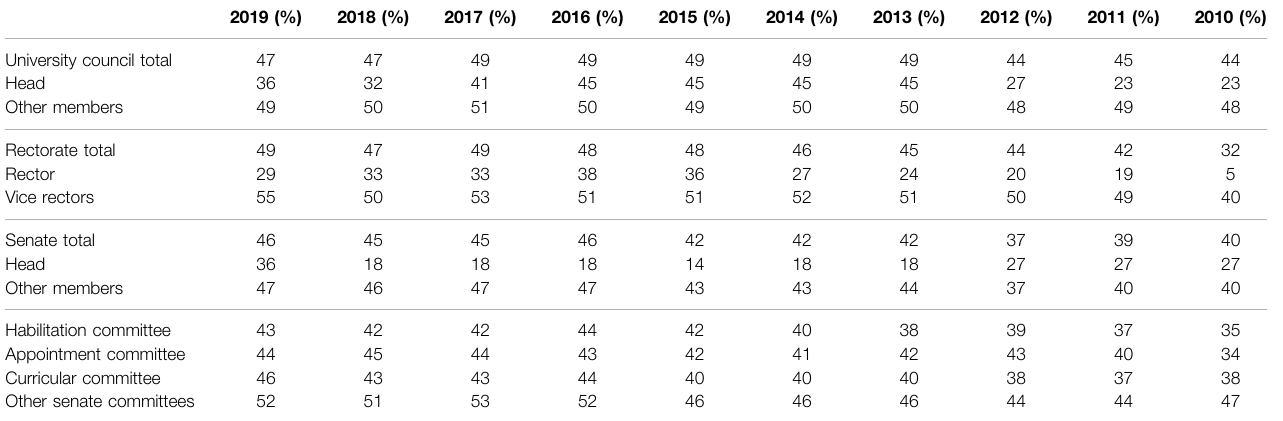
TABLE 1 | Share of women in university councils, rectorates, senates, and senate committees (2010 –